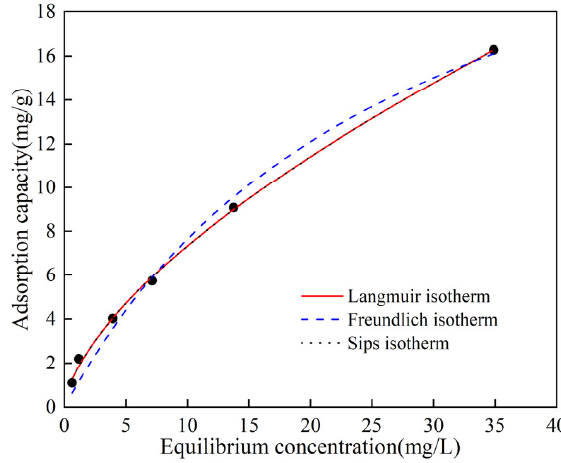
Figure 12. Adsorption isotherm of ammonia nitrogen on NaOH ‐ CFA.